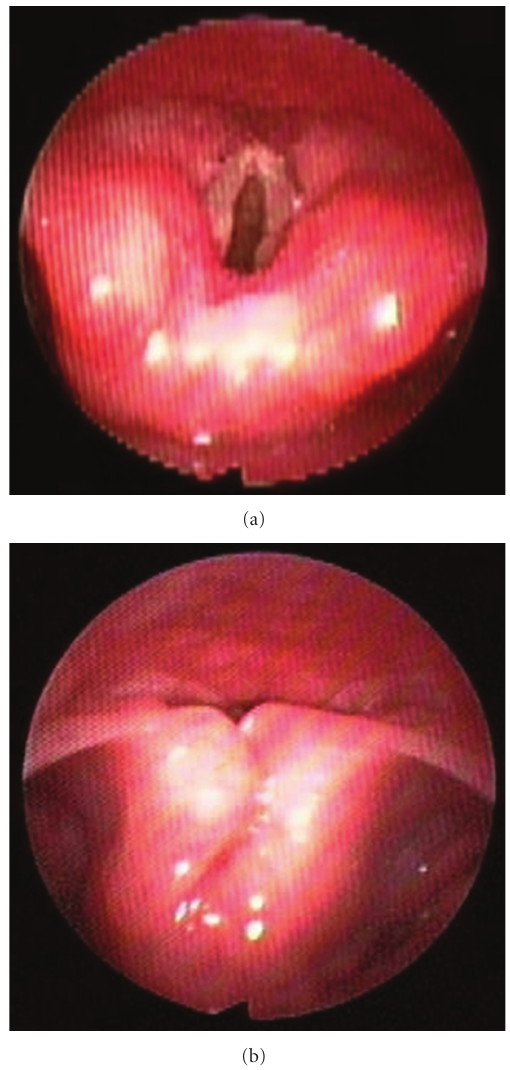
Figure 5: (a) Supraglottis of an older child with occult laryngo- malacia prior to inspiration. (b) Upon inspiration, the redundant arytenoid mucosa prolapses into the laryngeal introitus causing